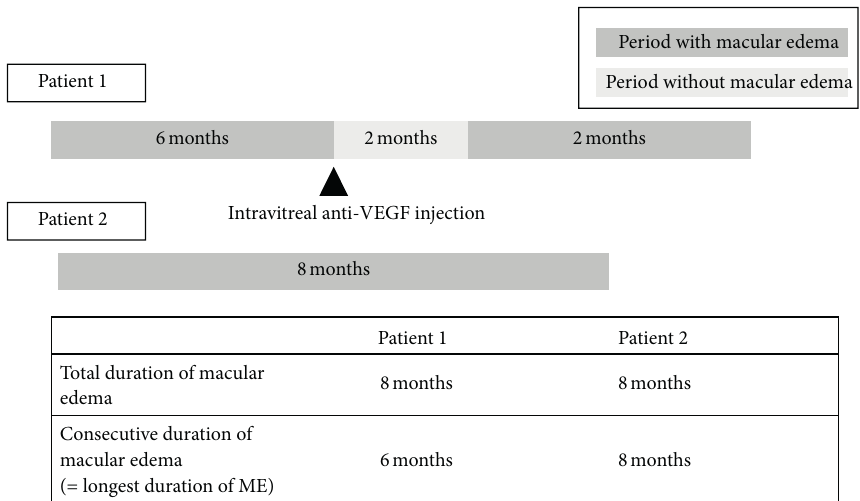
Figure 1: Concept of consecutive duration of macular edema. Patient 1 and patient 2 showed the same total duration of macular edema at the 8-month follow-up. However, different consecutive durations of macular edema were evident (6 months for patient 1 and 8 months for patient 2). VEGF = vascular endothelial growth factor.